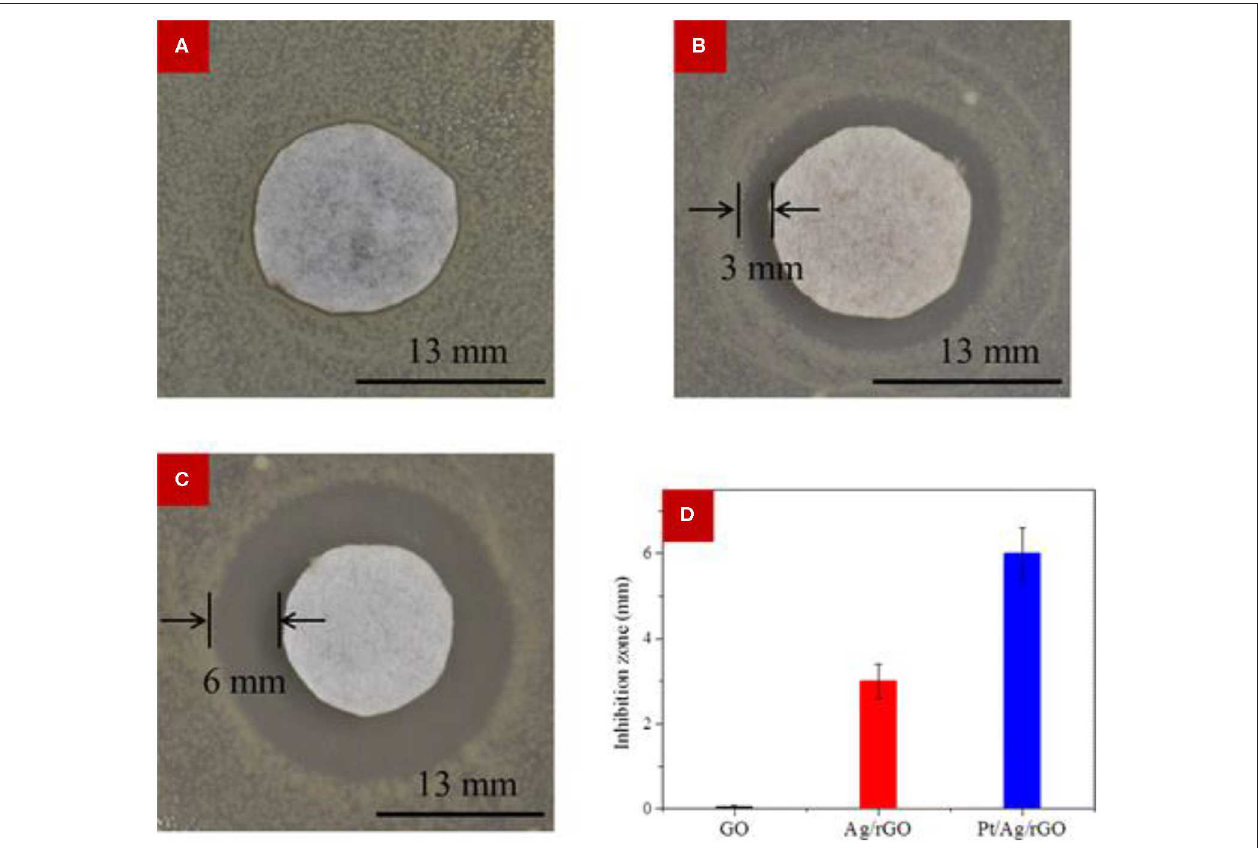
FIGURE 6 | Antimicrobial activity measurement using the modified Kirby–Bauer method. (A–C) Optical images of bacterial colonies against E. coli corresponding to (A) GO, (B) Ag/rGO, and (C) Pt/Ag/rGO. The Pt/Ag/rGO sample exhibited the largest inhibition zone. (D) Comparisons of the radius of the inhibition zone of bacteria treated with the different samples, revealing superior performance of the bimetallic material. Error bar is based on the average of three measurements. Reproduced from Zhang et al. (2016a) with permission from the American Chemical